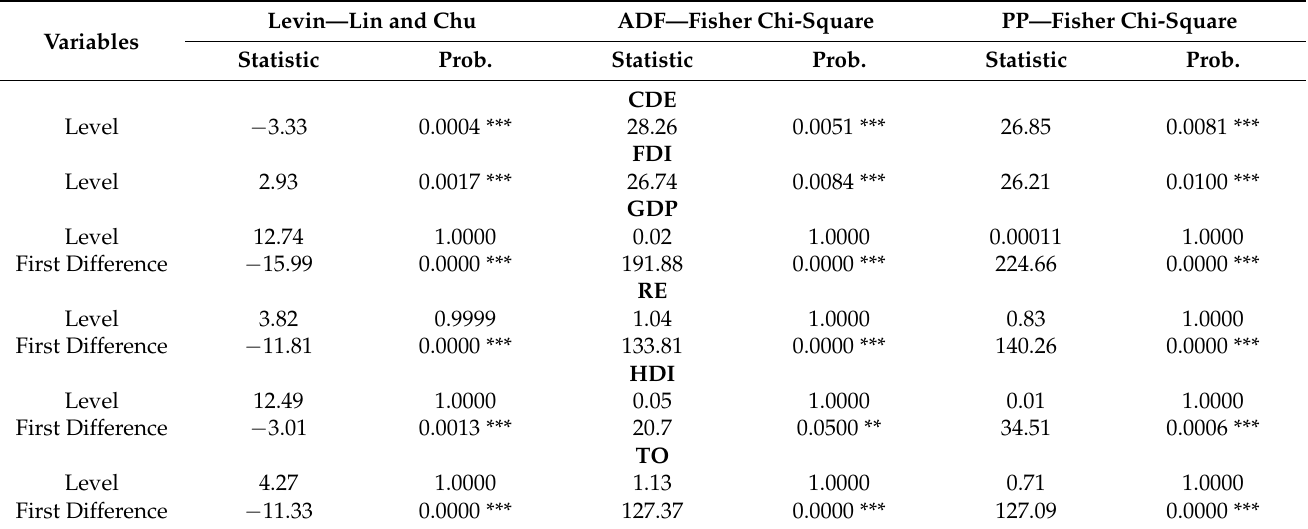
Table 3. Unit root tests for the full sample.